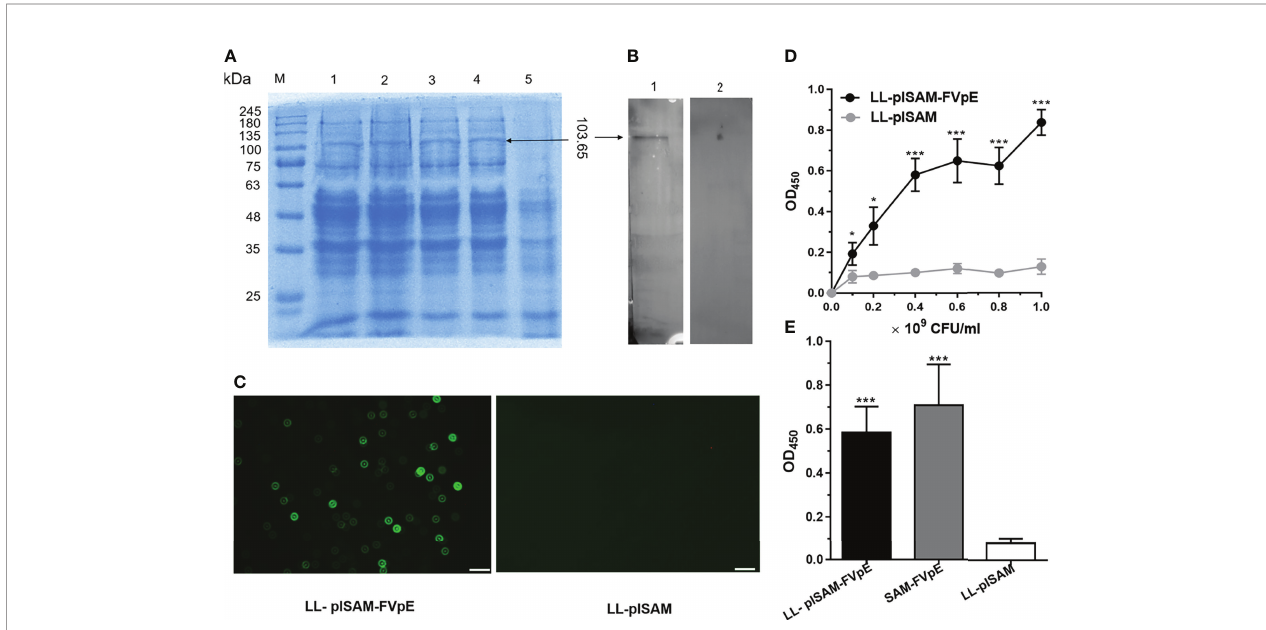
FIGURE 2 | Expression and identi fi cation of recombinant L. lactis vaccine LL-plSAM-FVpE. (A) SDS-PAGE. Protein marker (M); After induction with nisin, the lysate supernatants of LL-plSAM-FVpE (lane 1, 2, 3 and 4). The lysate supernatants of LL-plSAM-FVpE without induction with nisin (lane 5). (B) Western blot. The SAM-FVpE protein can be detected by mouse anti-FVpE antibody (lane 1). The SAM-FVpE protein was not detected by normal mouse serum (lane 2). (C) Immuno fl uorescence. LL- plSAM-FVpE or LL-plSAM were stained with mouse anti-FVpE antibody and FITC labeled goat anti-mouse IgG. (D) Whole cell ELISA. Different amounts of L. lactis LL- plSAM-FVpE or LL-plSAM were immobilized on ELISA plates. The protein SAM-FVpE was detected with mouse anti-FVpE and HRP-labeled Goat Anti-Mouse IgG. *p <0.05, ***p <0.001. (E) Whole cell ELISA. The plates were coated with LL-plSAM-FVpE (5 × 10 8 CFUs/well), LL-plSAM (5 × 10 8 CFUs/well) and the protein SAM-FVpE (0.5 m g/well). The protein SAM-FVpE was detected with mouse anti-FVpE antiserum and HRP-labeled Goat Anti-Mouse IgG. ***p